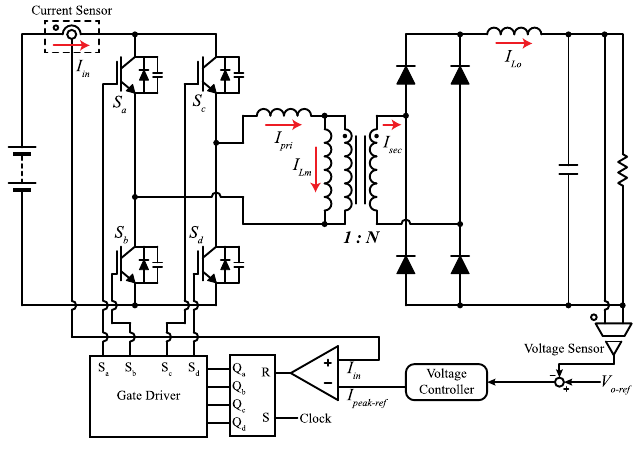
Figure 4. Circuit diagram of peak current-mode control (PCMC)-based PSFB converters.